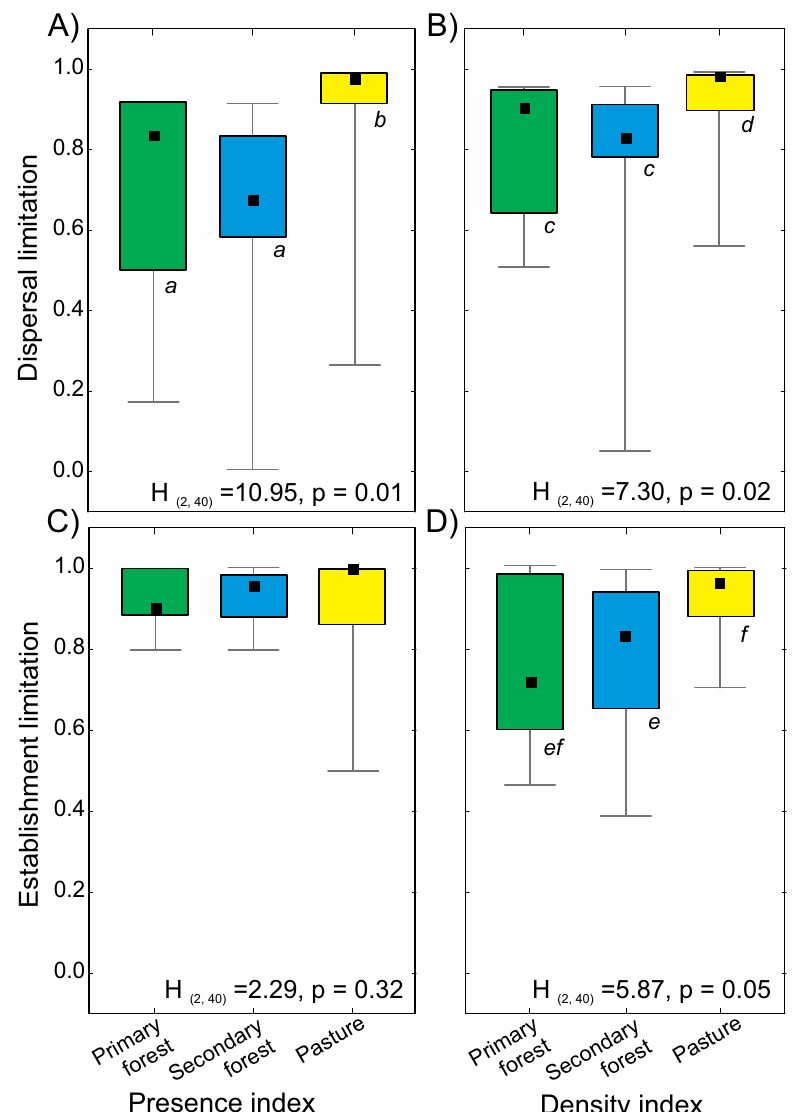
Figure 2. Comparison of presence and density indices for primary forest, secondary forest, and fenced pasture at Los Tuxtlas, southern Mexico. Presence and density-weighted indices are shown for dispersal limitation ( A and B , respectively), and for establishment limitation ( C and D , respectively). Squares show medians, boxes are quartiles and bars indicate highest and lowest values. Green boxes show the primary forest, blue boxes, the secondary forest and yellow boxes, the pasture. Different letters indicate significance based on multiple comparison z-tests within each frame. See text for relevant comparisons between frames.